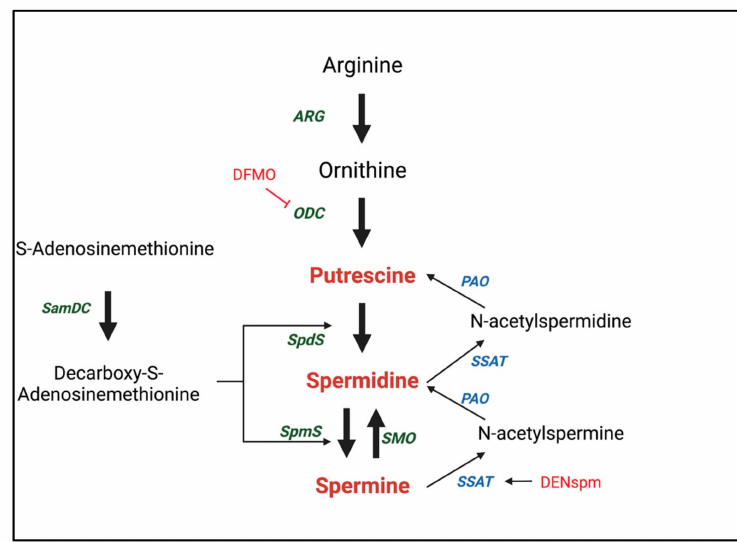
Figure 1. Polyamines Biosynthesis and Catabolic Pathway . Polyamine biosynthesis begins